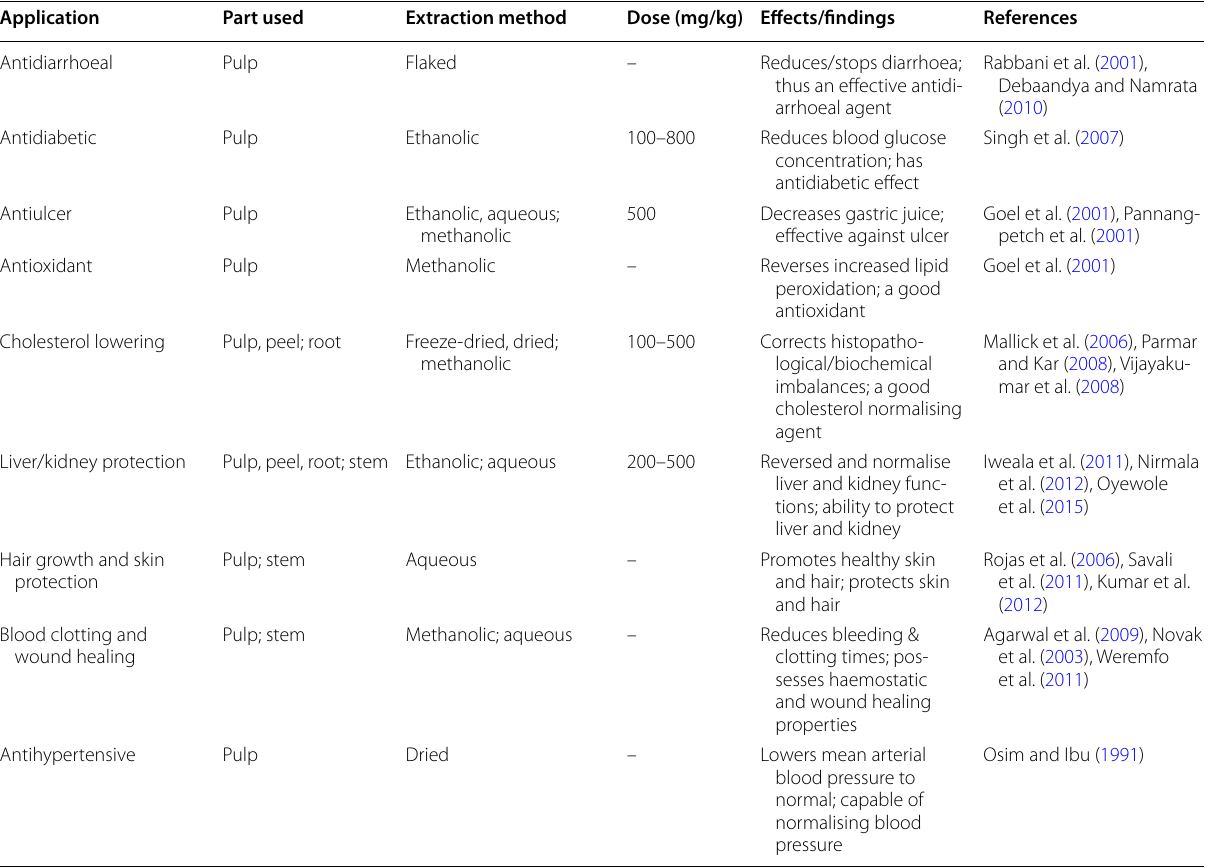
Table 2 Comparative analyses of traditional and medicinal applications of plantain parts